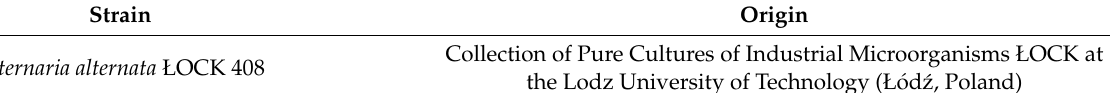
Table 1. Origin of the phytopathogen strains used in the research. Strain Origin Collection of Pure Cultures of Industrial Microorganisms ŁOCK